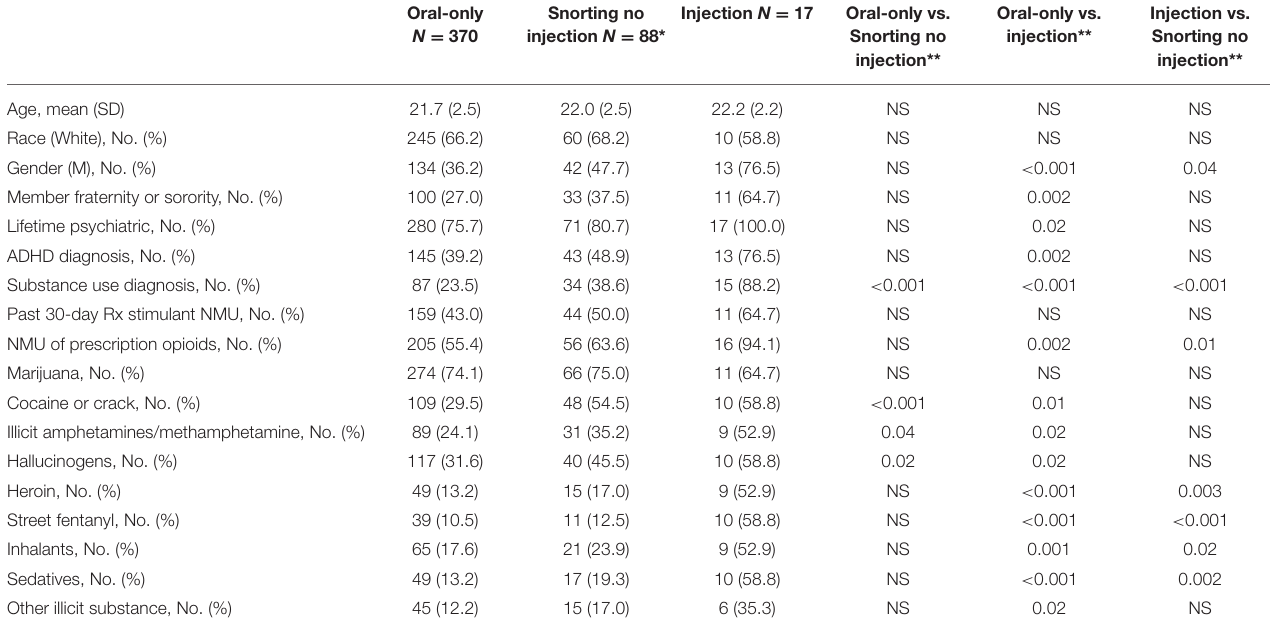
TABLE 4 | Exploratory factors associated with ROA patterns reported for prescription stimulants.